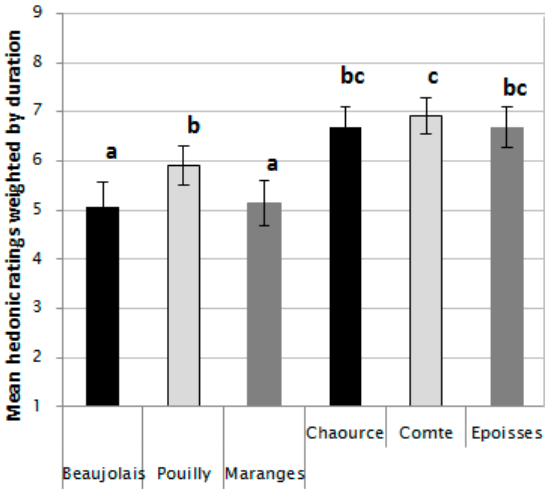
Figure 4. Weighted mean liking scores given to the products when tasted on their own in mono-intake. Different letters represent significant differences ( p < 0.05) according to LSD test.